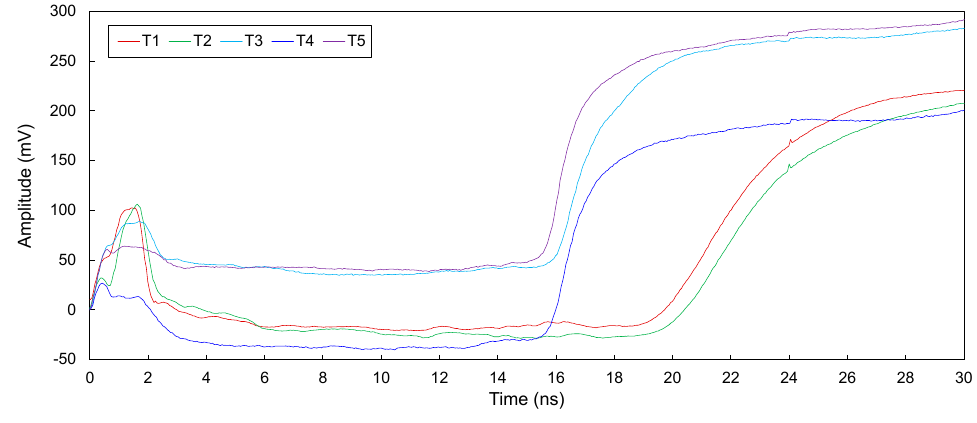
Figure 7. Measured signals for the intact transmission lines (T1 − T5). Table 2. Travel times of electromagnetic waves reflected from the ends ( ∆ t end ) and velocities ( v p ) in the transmission